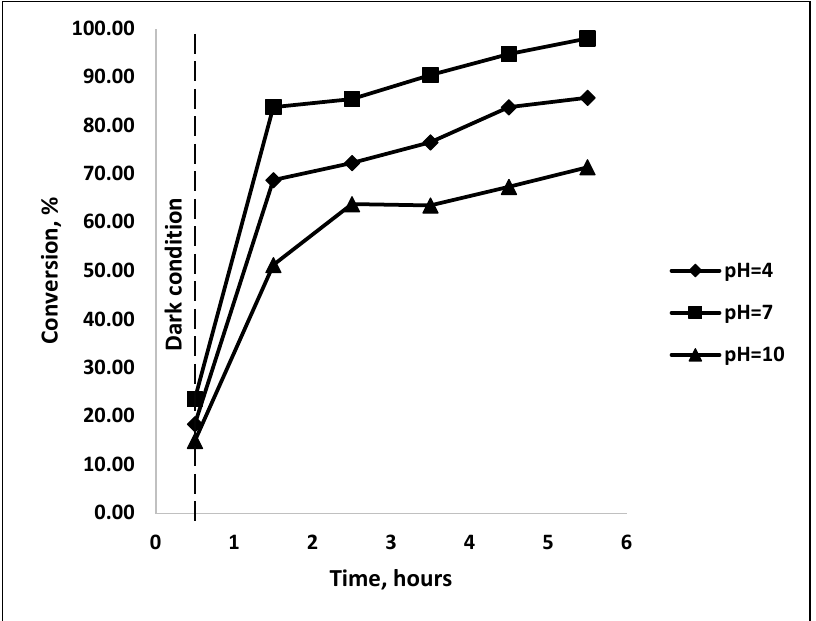
Figure 12. Impact of pH on CIP conversion rate.